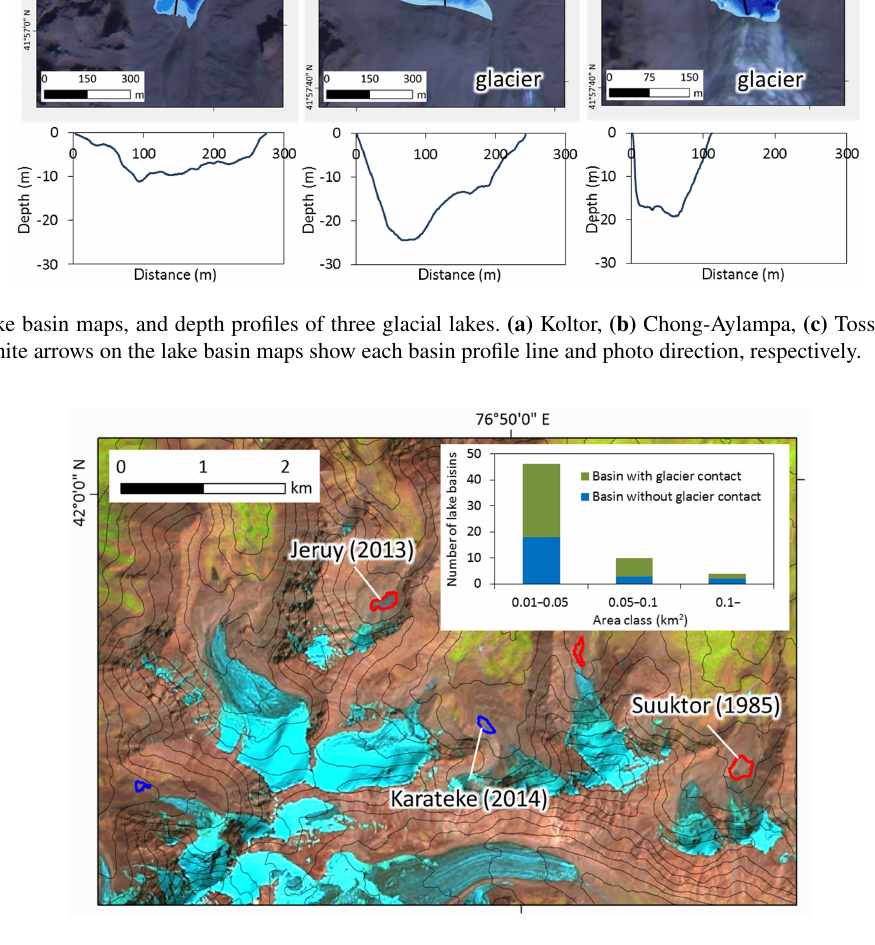
Figure 8. Depressions at glacier fronts in the study area (locations in Fig. 1). Red lines outline depressions with glacier contact and blue lines outline depressions without glacier contact. The inset shows size, number, and type (with glacier contact or without glacier contact) of depressions in the study